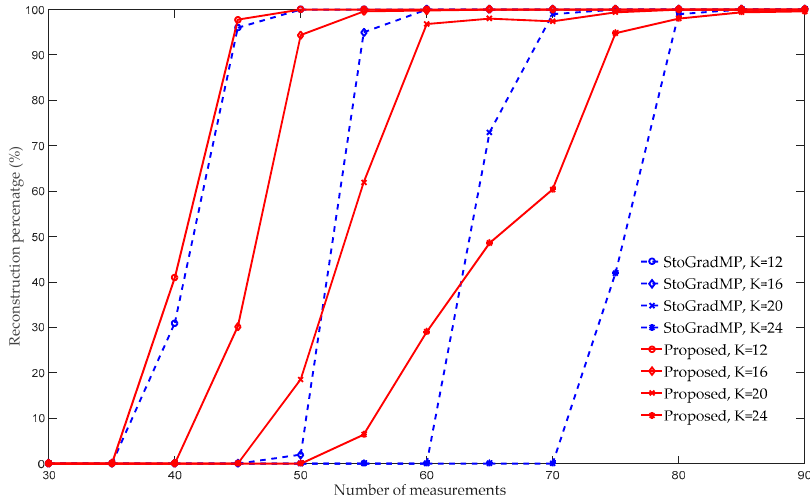
Figure 5. Reconstruction percentages of the StoGradMP and proposed algorithms ( n = 256, κ = 0.6, K = 12,16,20,24, m = 20 : 5 : 90, Gaussian , Gaussian signal).